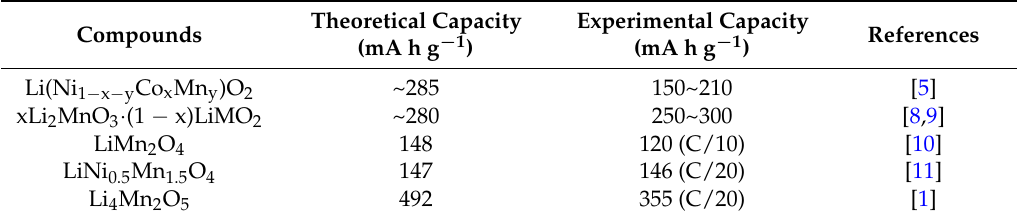
Table 1. The specific capacity of several Mn-based